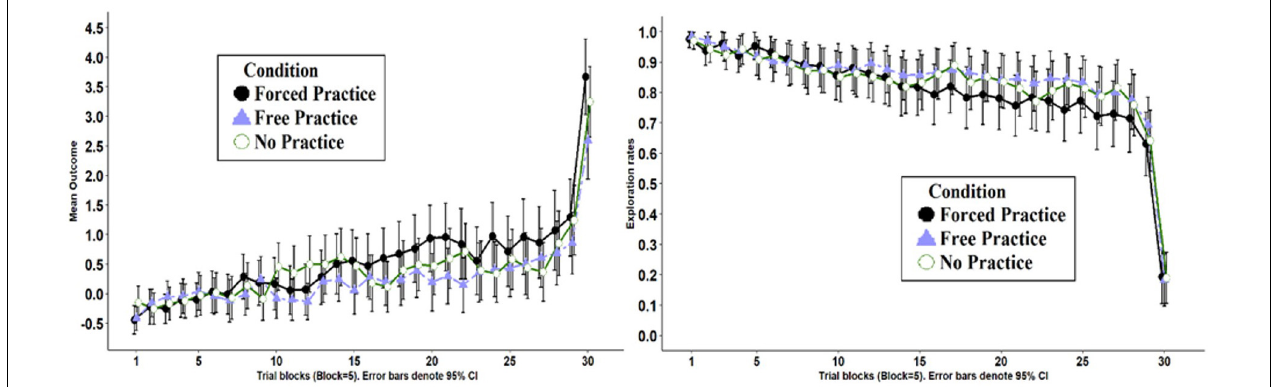
FIGURE 2 | Left: mean outcome in trial blocks in Game 2 (each block equals five trials), across the three Conditions of Study 1. Right: choice rates implying choice of unexplored keys in Game 2 (each block equals five trials), across the three Conditions of Study 1. The right panel of Figure 2 presents the mean exploration rates across the 150 trials in the three